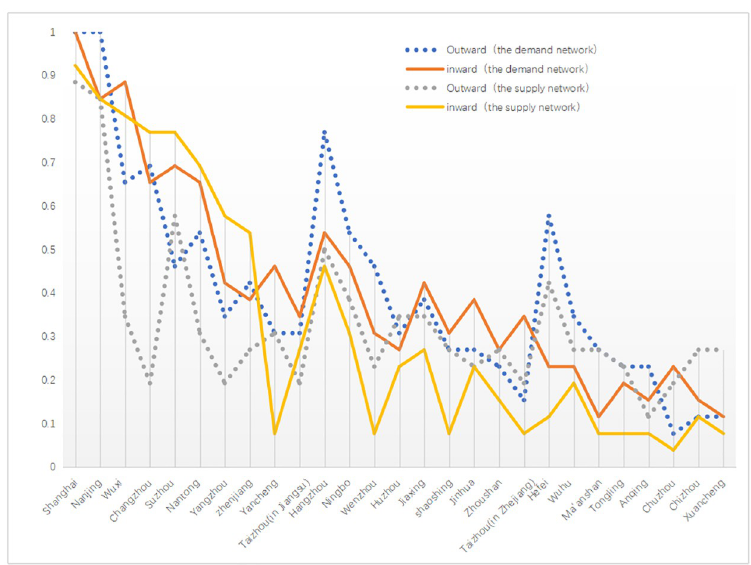
Fig 4. The degree centrality indexes of supply and demand networks in regional tourism